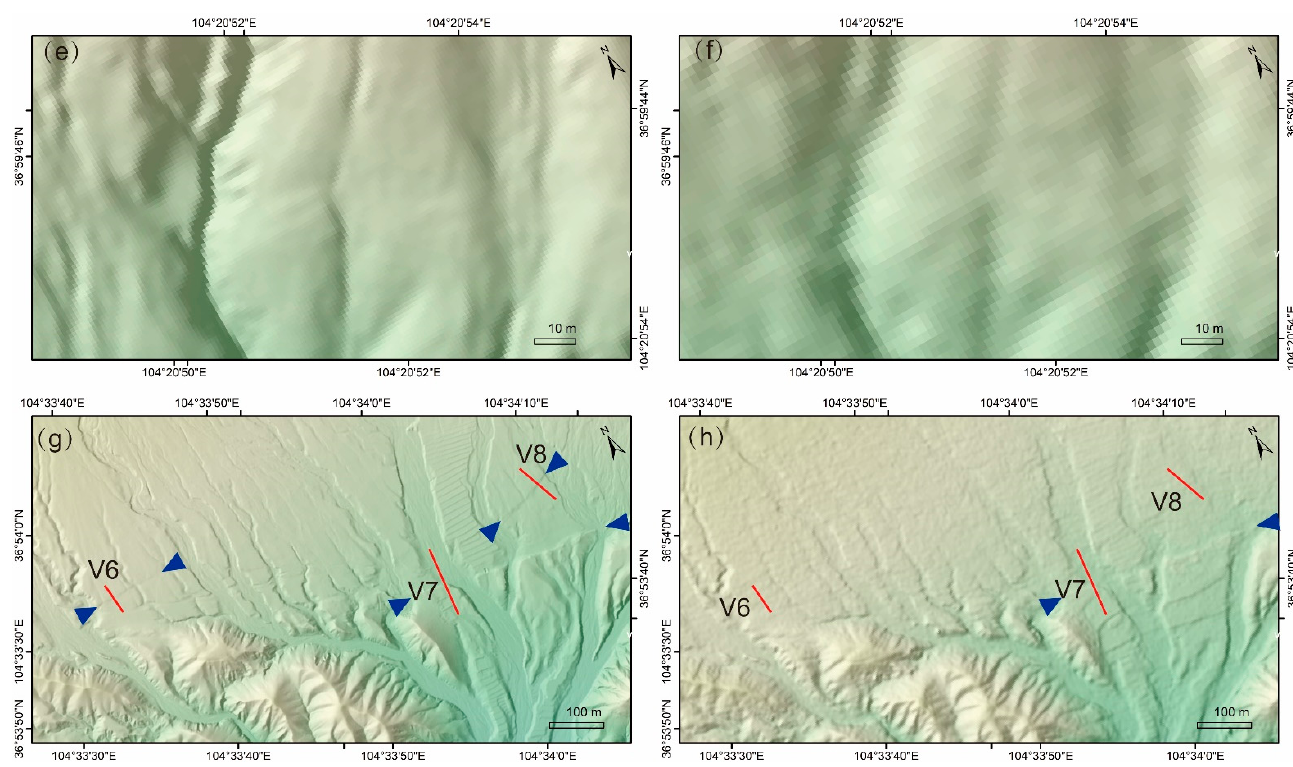
Figure 11. The fault features identified by the airborne LiDAR-derived DEM with a 1 m resolution ( a , c , e , g ) and GF-7 DEM with a 2 m resolution ( b , d , f , h ). The blue triangles represent the faults iden- tified.